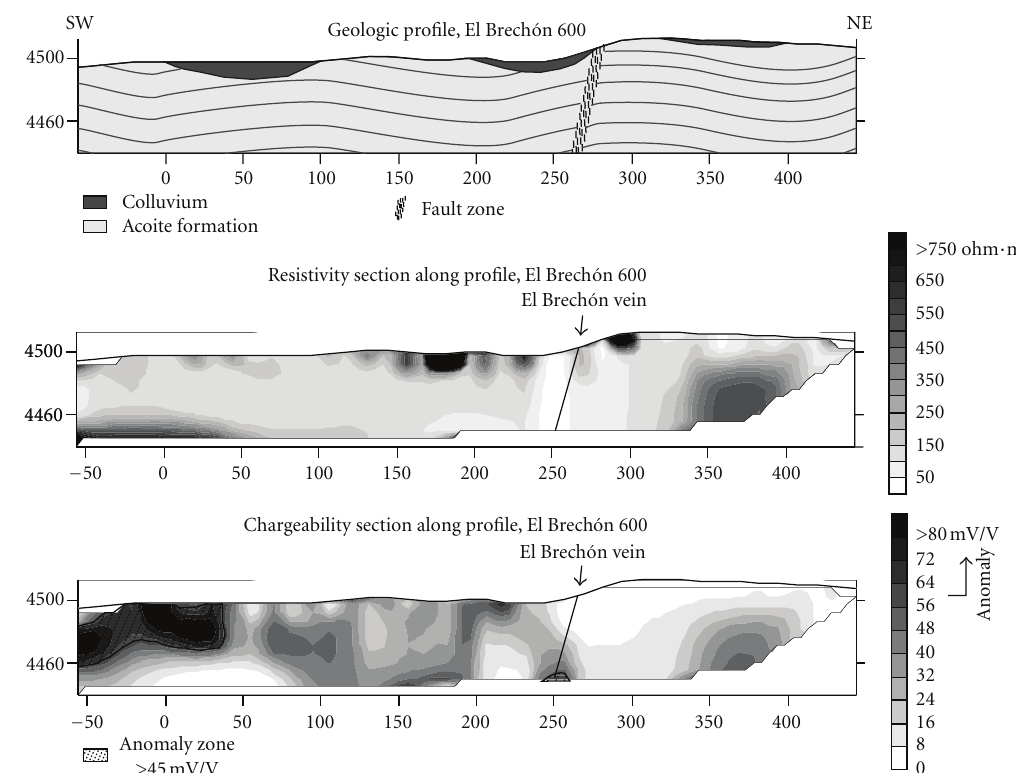
Figure 8: Geological, resistivity, and chargeability profile no. 600 for El Brech´on section. The vein is spatially associated with a low-resistivity tabular area. An extensive area presenting anomalous chargeability is noted on the SW section of the profile and a smaller one in the deep zone (below ∼ 50m) of the